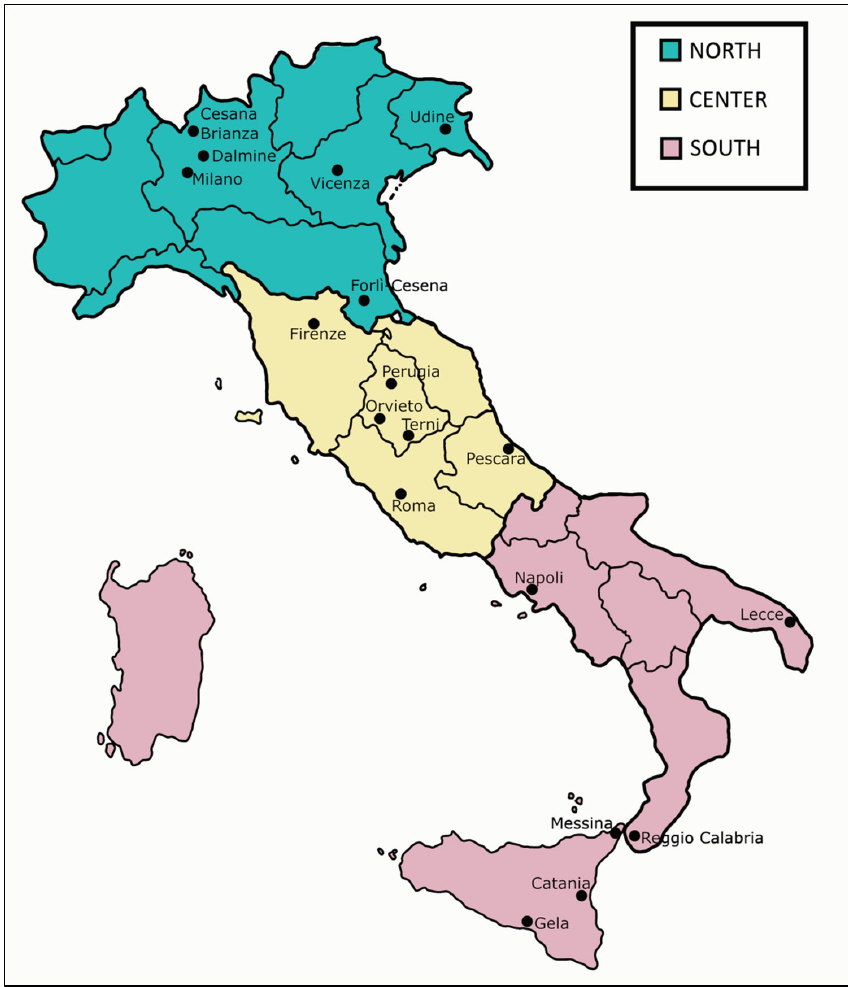
Figure 1. Collection sites of the sushi survey in Northern (green), Central (light yellow) and Southern (pink) Italy.